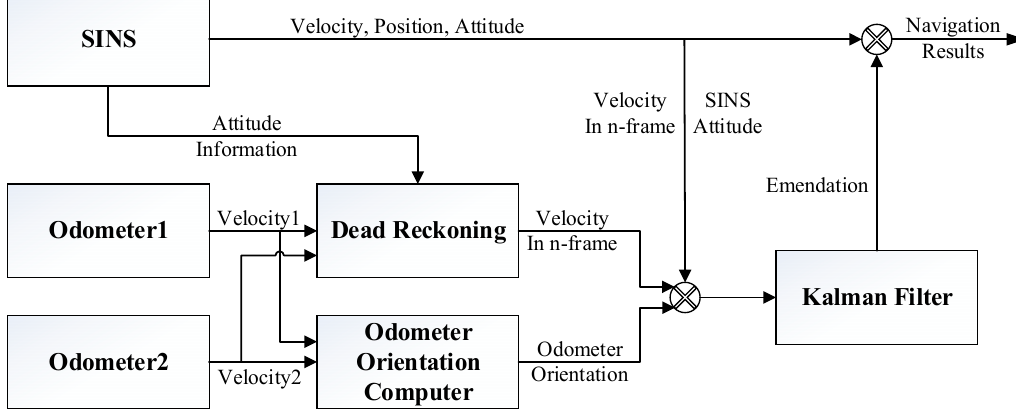
Figure 2. Schematic for the integrated navigation method.